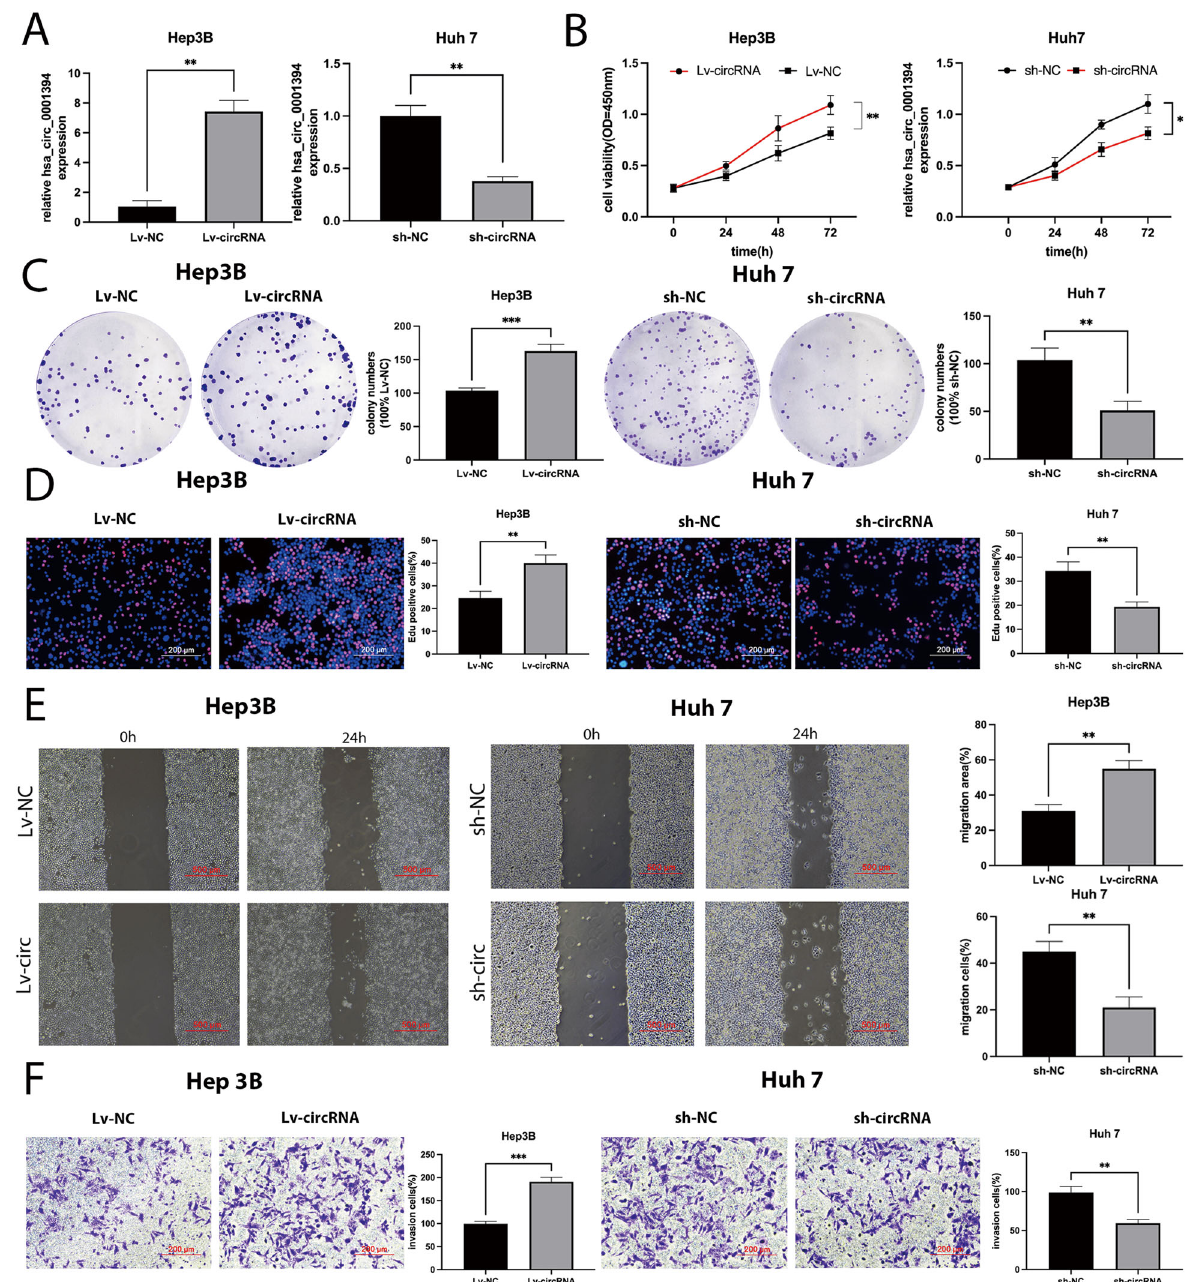
Fig. 2 Hsa_circ_0001394 promotes the proliferation, migration, and invasion of HCC cells in vitro. A Relative expression of hsa_circ_0001394 overexpression and knockdown in Hep3B and Huh7 cells was detected by qRT-PCR. The overexpression system in Hep3B cells was constructed after stable transfection with pcDNA3.1( + ) circRNA vectors for overexpressing hsa_circ_0001394 (Lv-circ). Lv-NC served as control plasmids of Lv-cric. The knockdown system in Huh7 cells was constructed after stable transfection with the short hairpin RNA target hsa_circ_0001394 (sh-circ). Sh-NC served as control plasmids of sh-circ. B The growth of Hep3B cells transfected with Lv-hsa_circ_0001394 (Lv- circ) and Huh7 cells transfected with sh-hsa_circ_0001394 (sh-circ) was evaluated using a CCK-8 assay. C Colony formation experiments showed that hsa_circ_0001394 promoted the colony formation activity of HCC cells. D Comparison of HCC cells transfected with Lv- hsa_circ_0001394 (Lv-circ) or sh-hsa_circ_0001394 (sh-circ) and corresponding control groups in EdU assays. E Wound-healing assays were performed to detect the effect of hsa_circ_0001394 on HCC cell migration ability. F Transwell assays were used to measure the effect of hsa_circ_0001394 on HCC invasion capacity. Lv-circ, pcDNA3.1( + ) circRNA vector for hsa_circ_0001394 overexpression; Lv-NC, negative controls of Lv-circ; sh-circ, short hairpin RNA targeting hsa_circ_0001394; sh-NC, negative controls of sh-circ. All values are presented as mean ± SD from three independent experiments with similar results. (* p < 0.05, ** p < 0.01, *** p < 0.001).